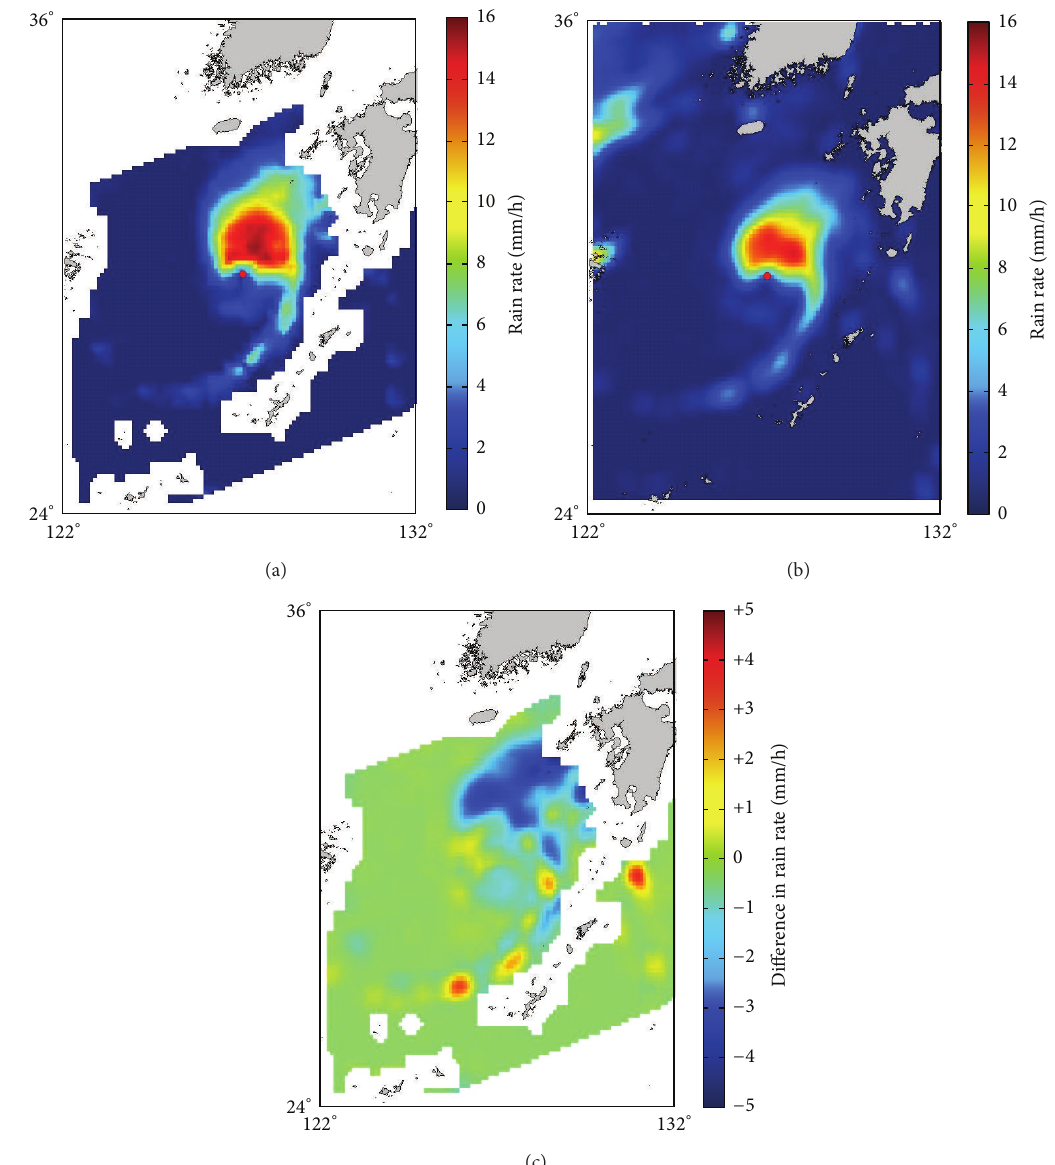
Figure 9: (a) TMI gridded (10km × 10 km) RR field (mm/h), 7 October 2013, 18:36 UTC; (b) AMSR2 derived gridded (10km × 10km) RR field (mm/h), 7 October 17:14 UTC, shifted to superpose the typhoon center with that of TMI; (c) RR